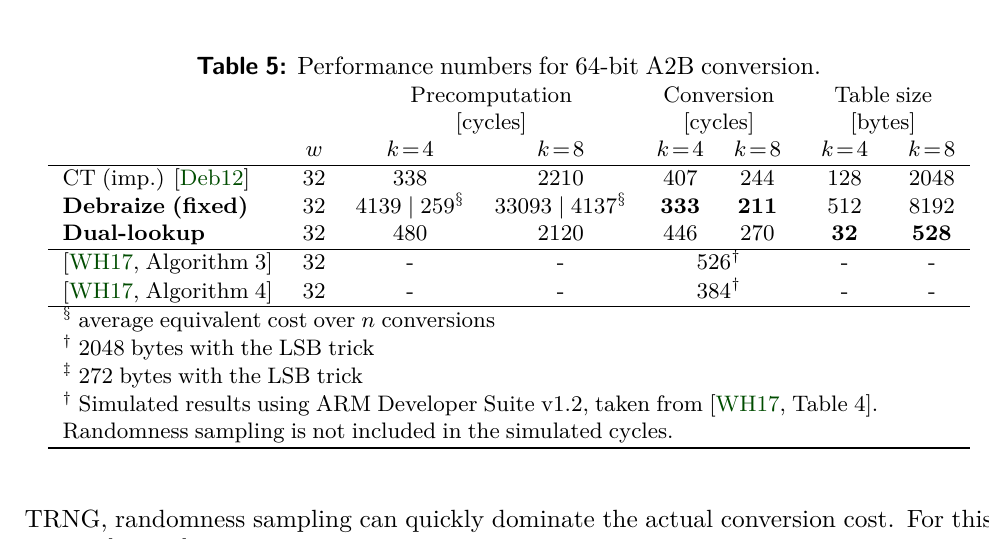
Table 5: Performance numbers for 64-bit A2B conversion.